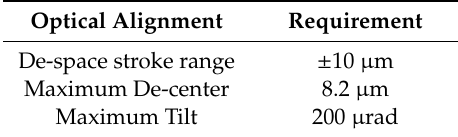
Table 3. The requirements of the optical alignments; De-space, De-center, and